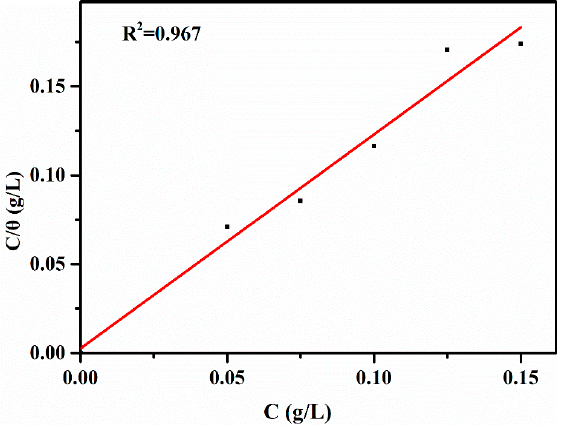
Figure 7. Langmuir adsorption model of iron in 1 mol/L HCl solution at room temperature. The Langmuir isotherm adsorption model of lignin-DMC in 1 mol/L HCl at 25 °C is shown in Figure 7. The values of Δ G were − 27.51 kJ/mol, − 28.42 kJ/mol and − 29.33 kJ/ mol at temperatures of 25, 35 and 45 °C, respectively, with the inhibitor at 75 mg/L. Negative values indicate that the